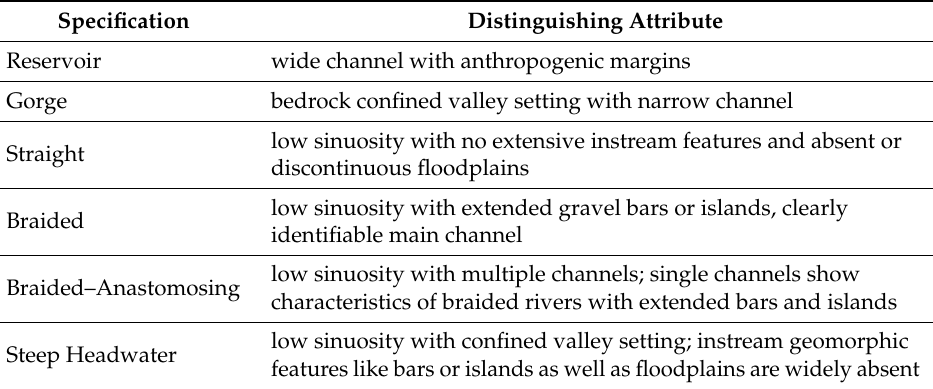
Table 2. River types and their distinguishing attributes used for channel planform